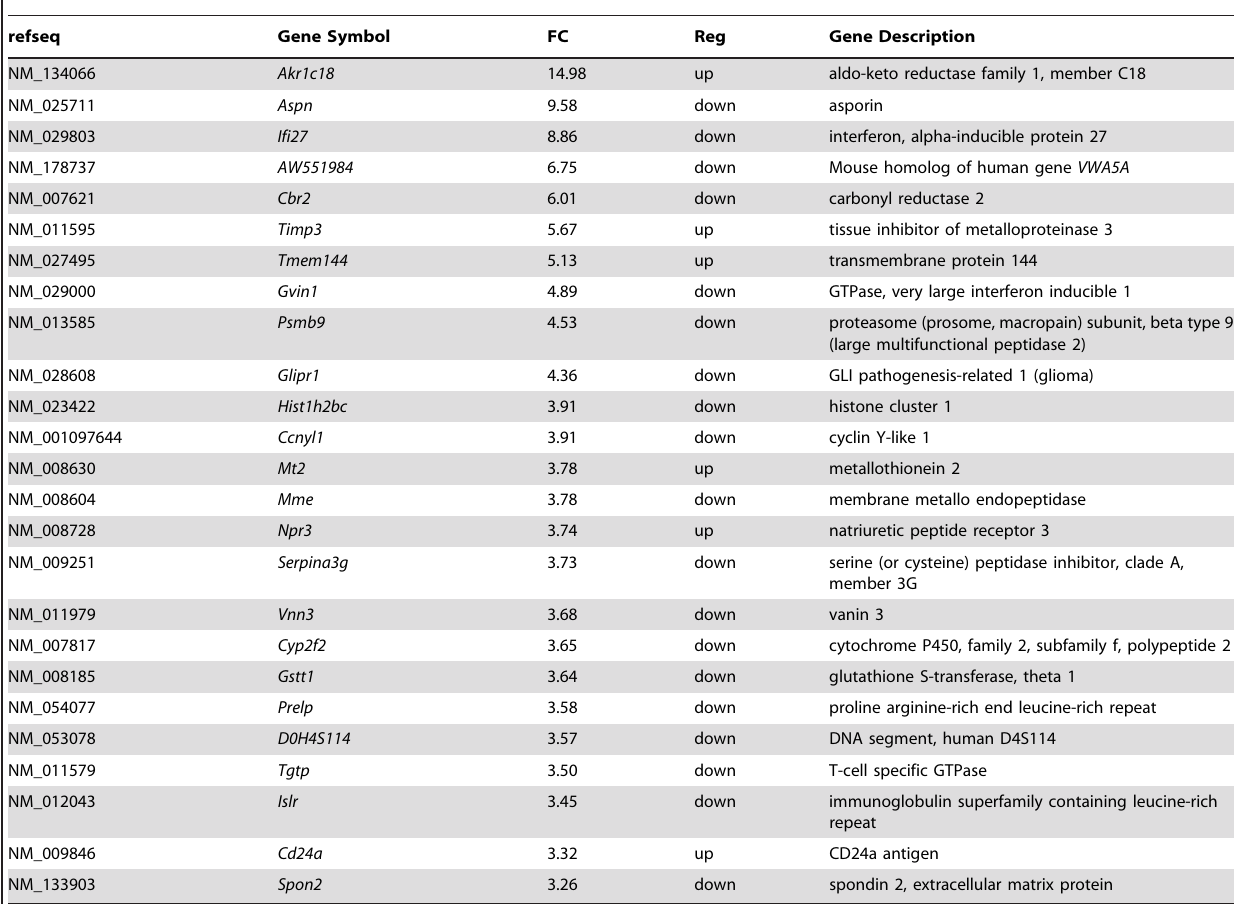
Table 2. Top 25 differentially expressed Affymetrix Mouse Exon 1.0 St Array probe sets in MEFs between the Mta1 knock out and Mta1 knock out/ Mta1